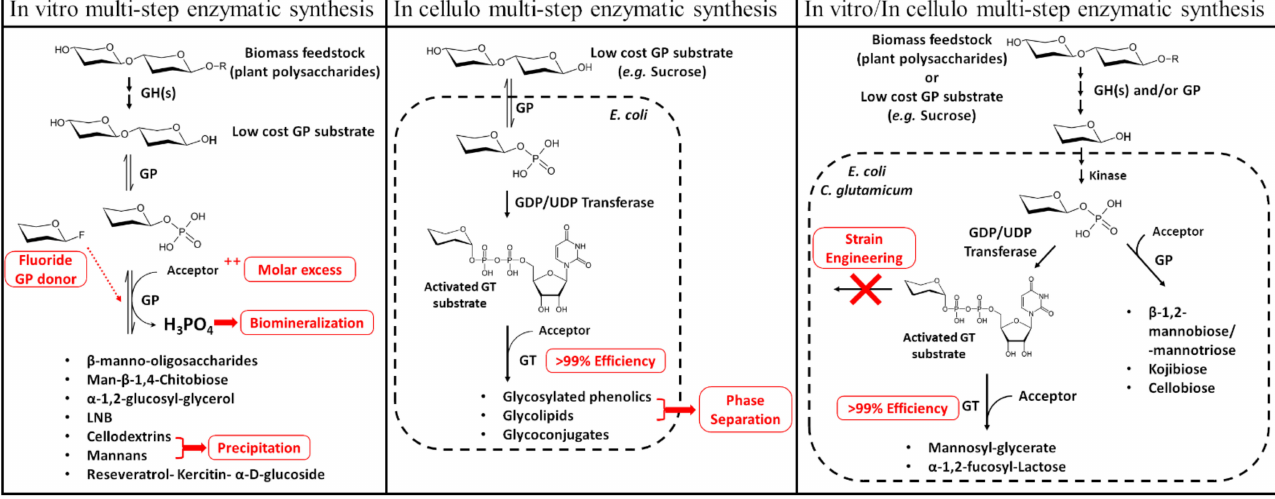
Figure 4. Biotechnological applications of GPs: the different strategies employed for improving glycoside production yields are marked in